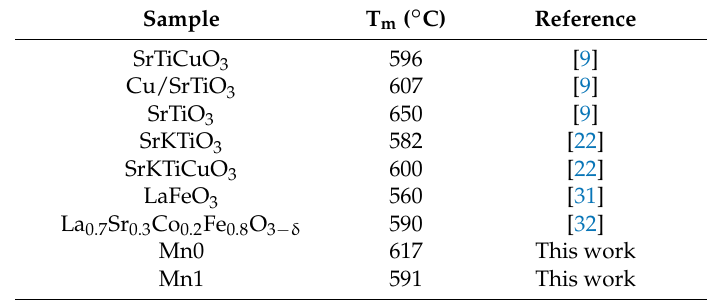
Figure 5. Soot catalytic reaction using catalysts synthesized in this work with different contents of Mn. ( a ) DTG; ( b ) activation energy by Kissinger method; and ( c ) TGA analysis. Table 4. Comparative of soot catalytic combustion temperature with previous reports using carbon Vulcan as soot model.